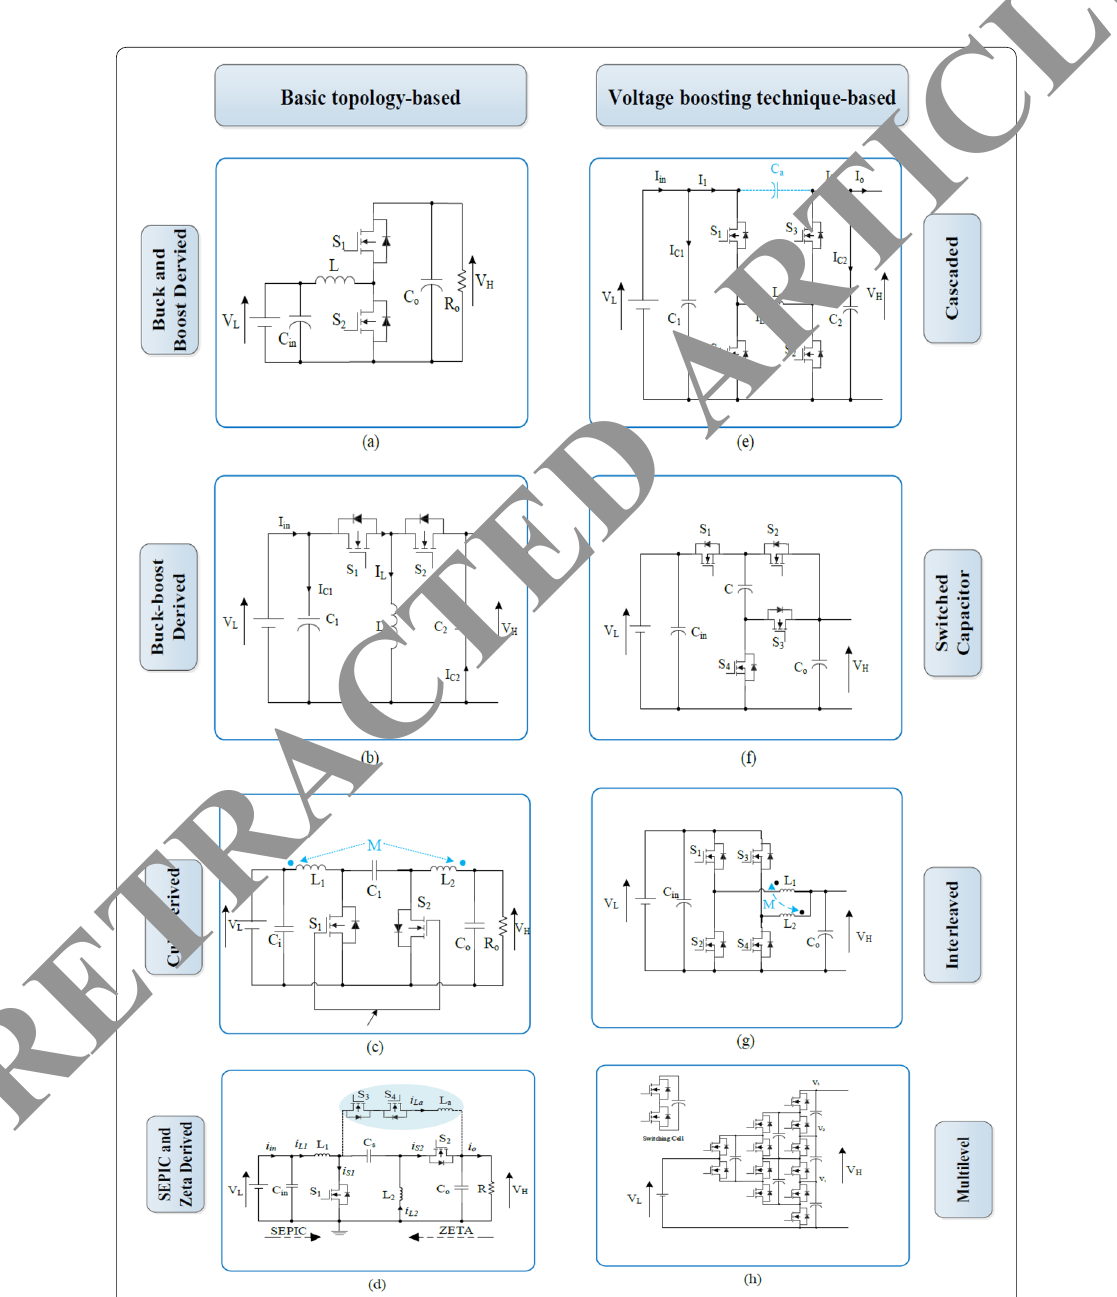
Fig. 7 Non-isolated Bidirectional DC-DC